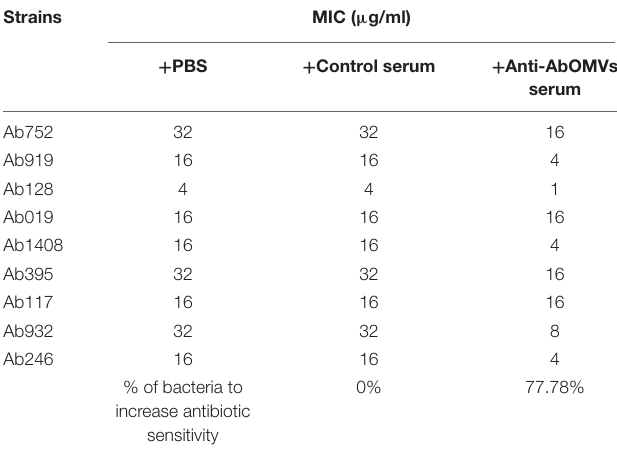
TABLE 2 | Determination of MIC values of different strains when anti-AbOMV serum was used together with levofloxacin. Strains MIC ( µ g/ml)